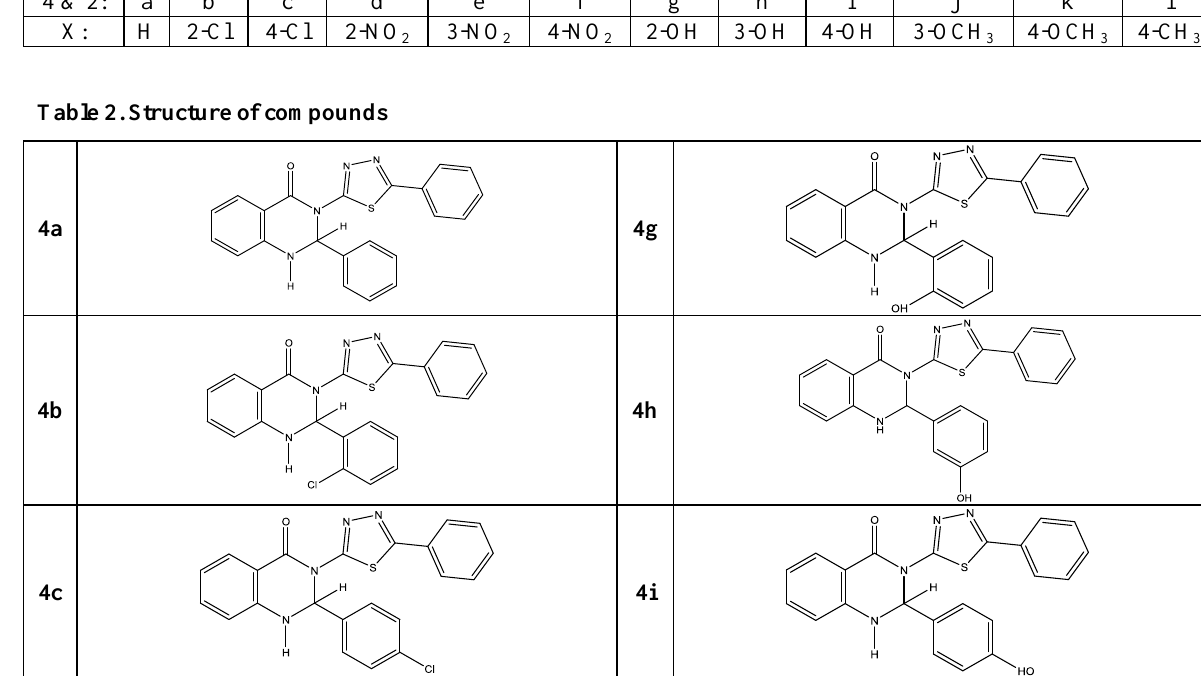
Table 1. groups (X) attached to benzaldehyde 258